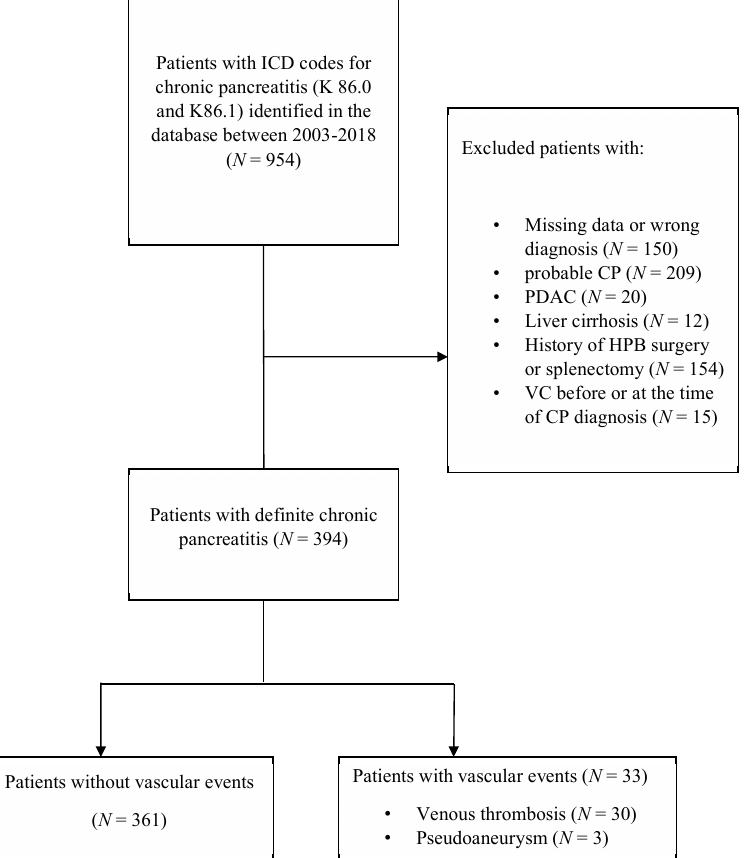
Figure 1. Flow chart of patient selection. CP—chronic pancreatitis; PDAC—pancreatic ductal adenocarcinoma; HPB—hepato-pancreatico-biliary.